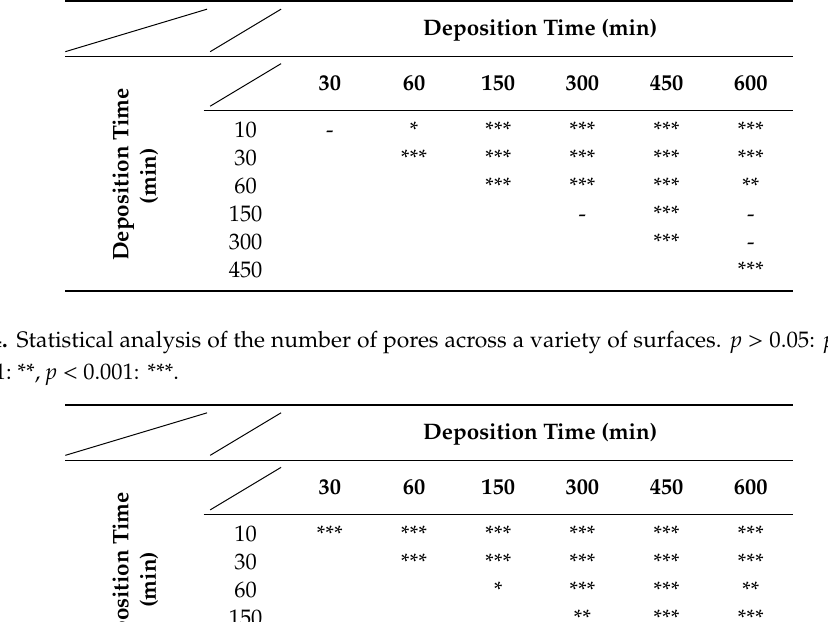
Table 3. Statistical analysis of the average Feret’s diameter of the pores across a variety of surfaces. p